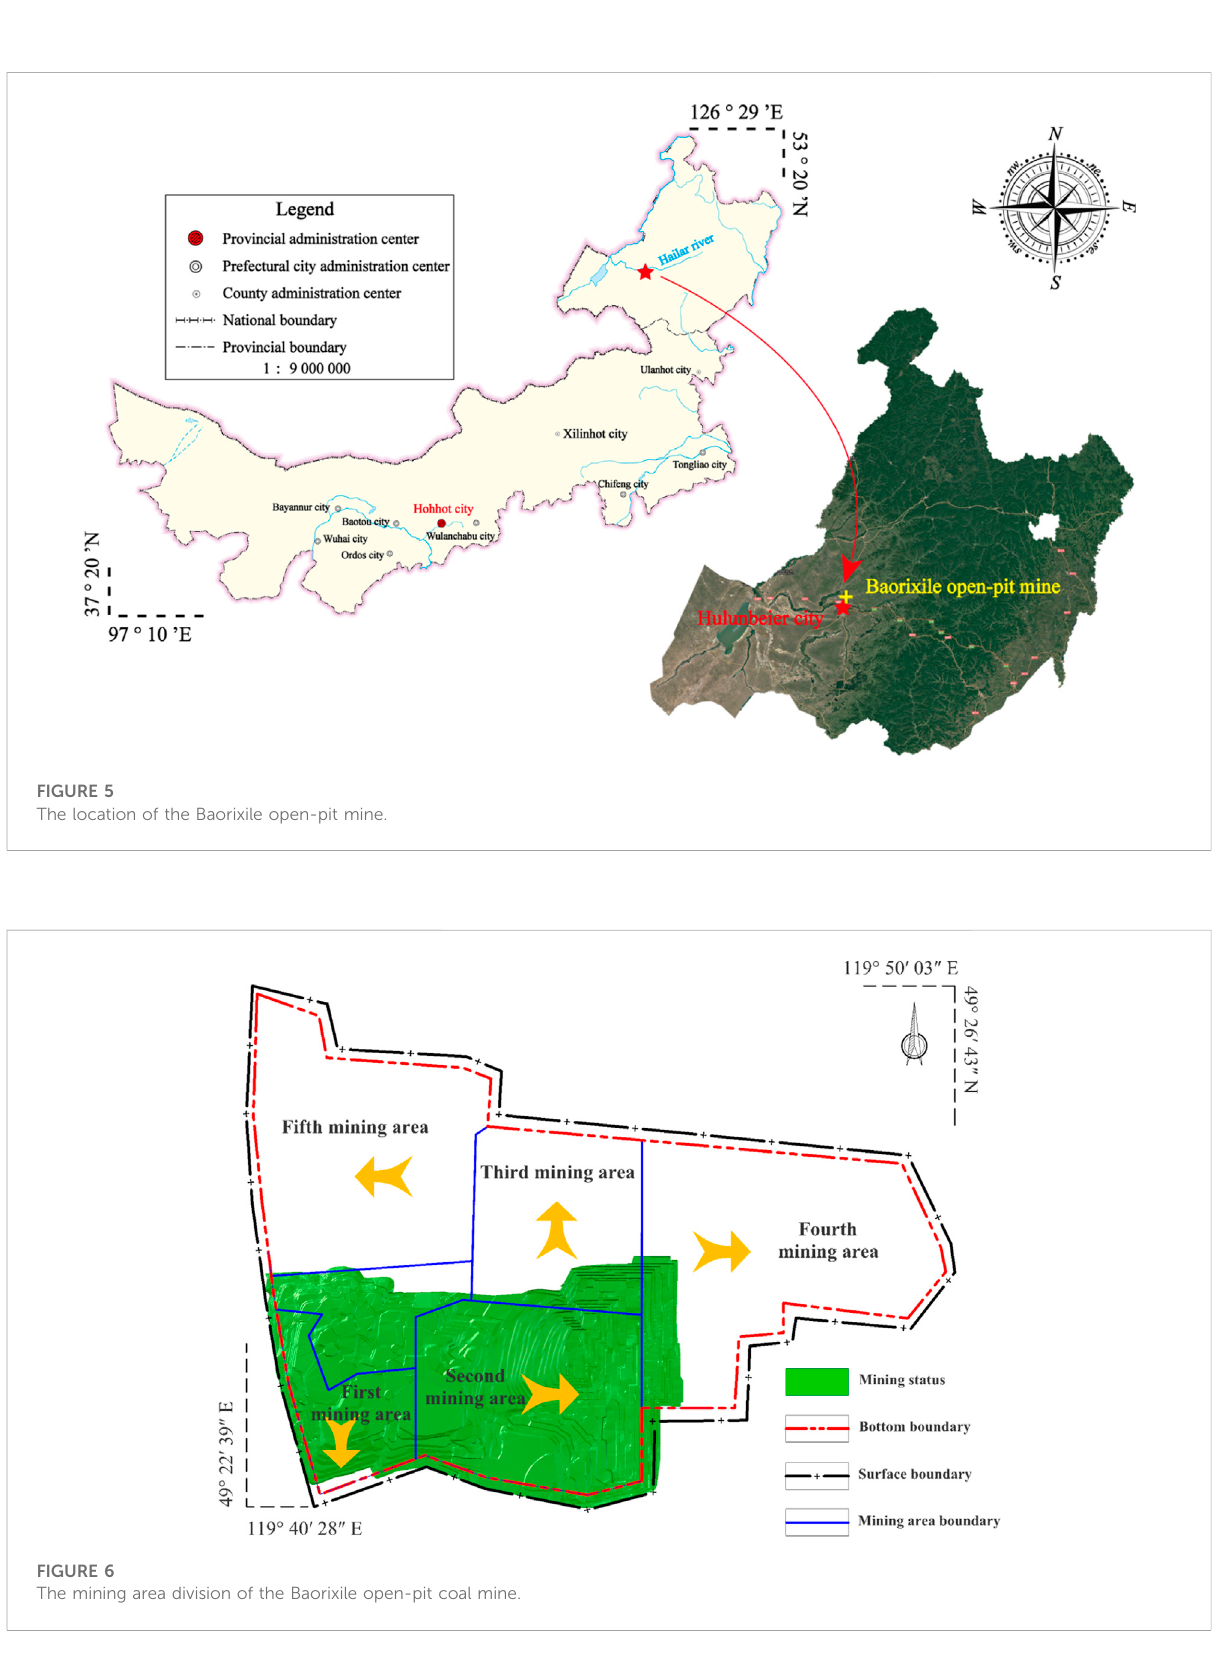
Frontiers in Earth